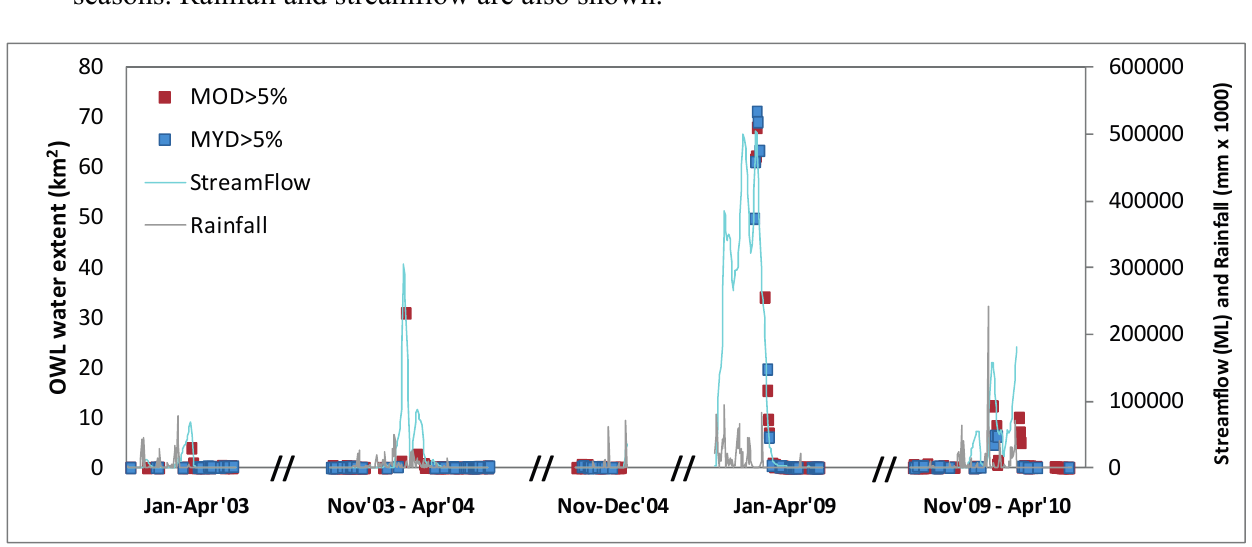
Figure 6. MODIS OWL flood extent (using only those pixels mapping greater than 5% seasons. Rainfall and streamflow are also shown.